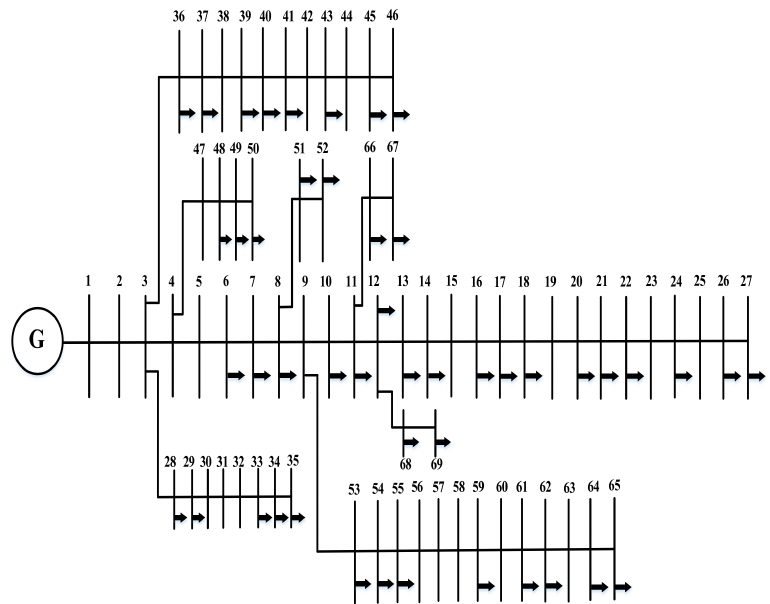
Figure 11. Single line diagram of IEEE 69-bus